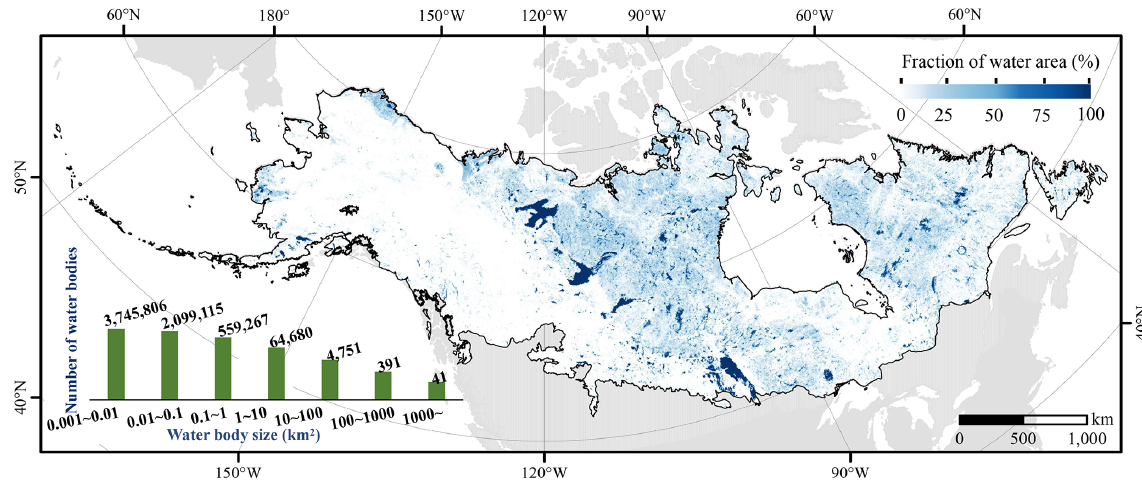
Figure 6. Percent of surface water (5km × 5km grid) produced by aggregating the water extent for the tundra and boreal forests of North America as calculated using the WBD-NAHL